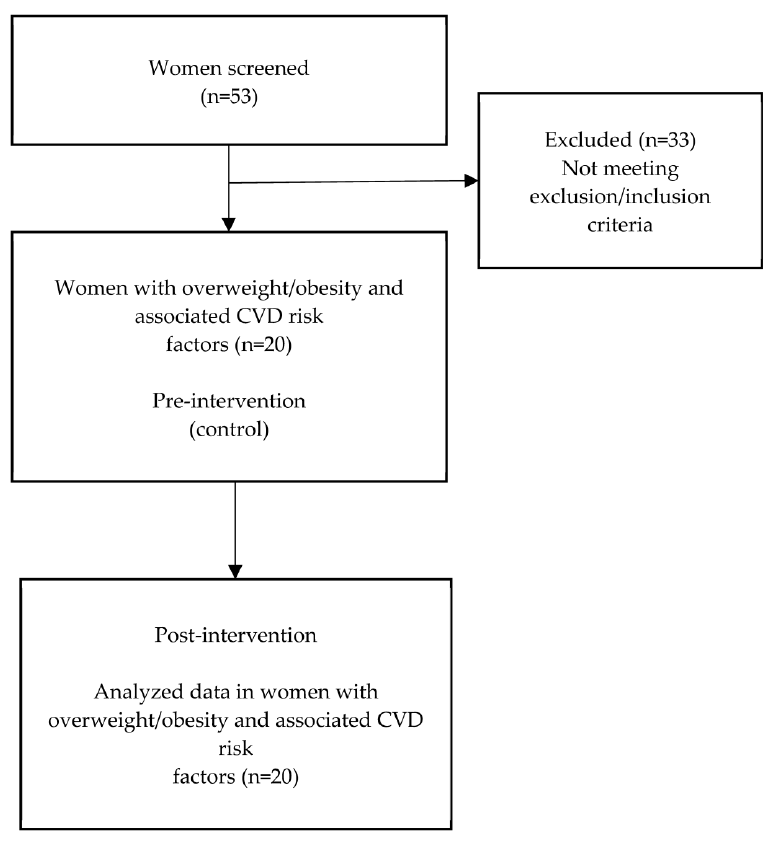
Figure 1. Flowchart of the pre – post intervention and completion of participant selection.